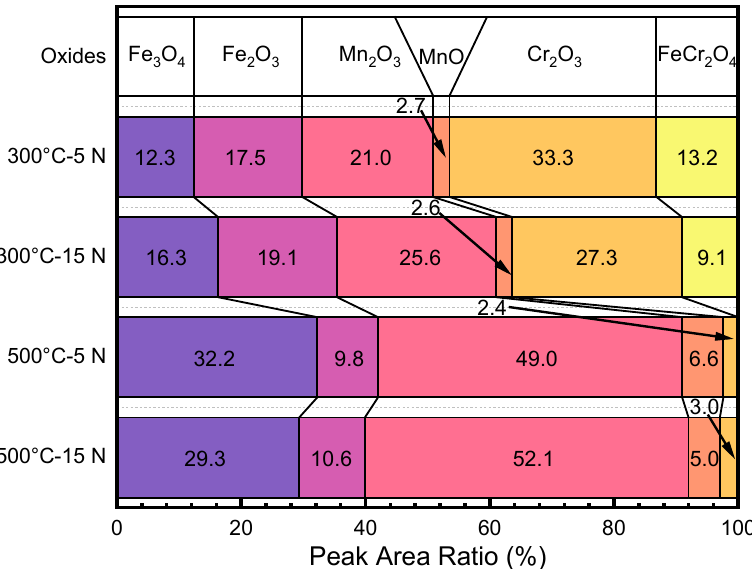
Figure 10. Contents of oxides under different